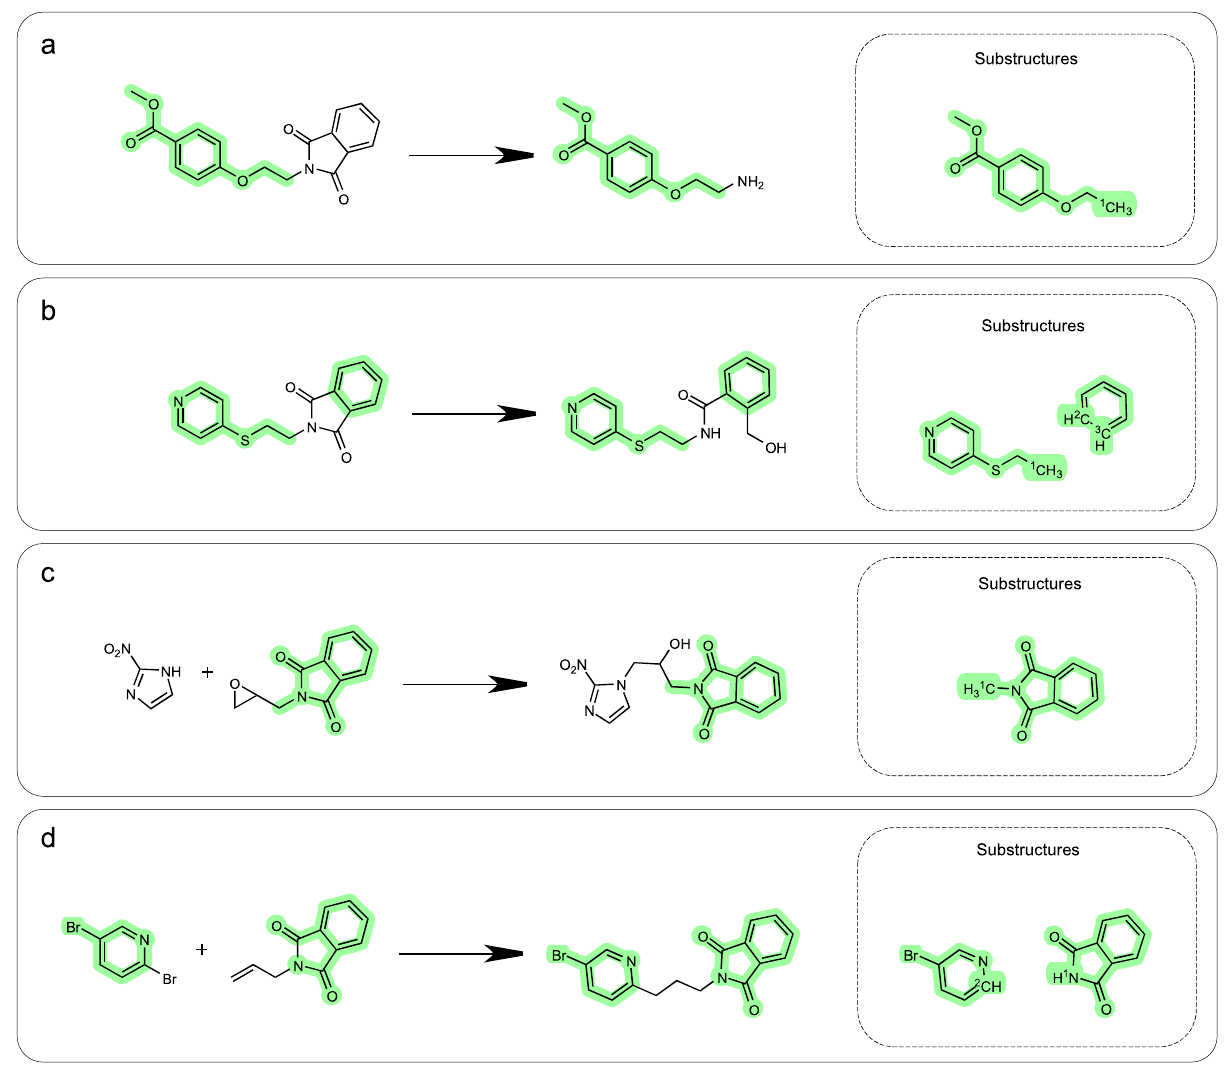
Fig. 4 | Product molecule speci fi c substructures. These reactants all contain phthalimide, with substructures highlighted in green. a In this hydrolysis reaction, the methyl 4-ethoxybenzoate on the nitrogen atom is extracted as sub- structure. b Inthisreductioninducedbysodiumborohydride,the4-(ethylsulfanyl)